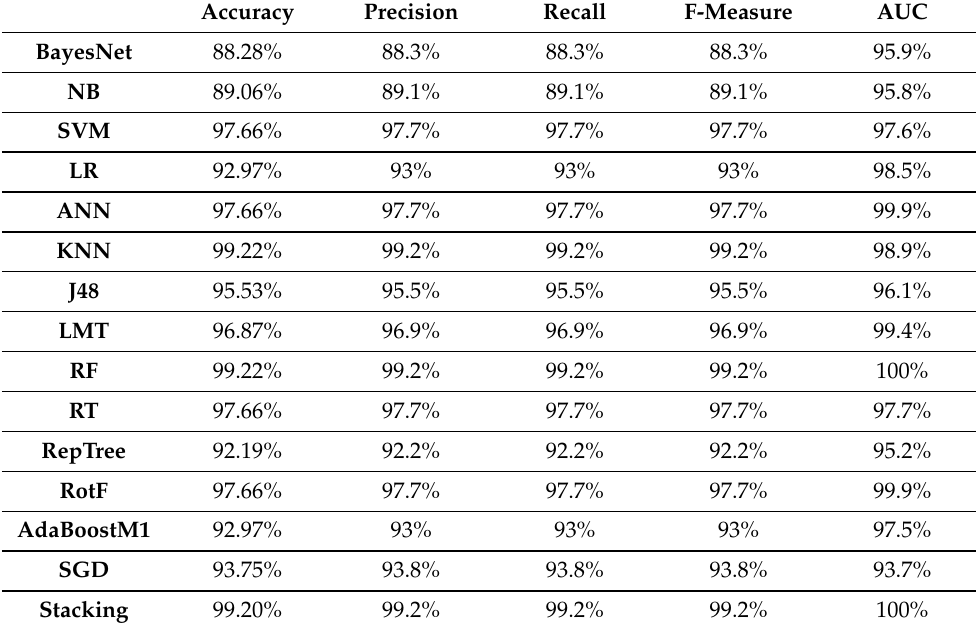
Table 6. Performance evaluation after SMOTE with percentage split (80:20).